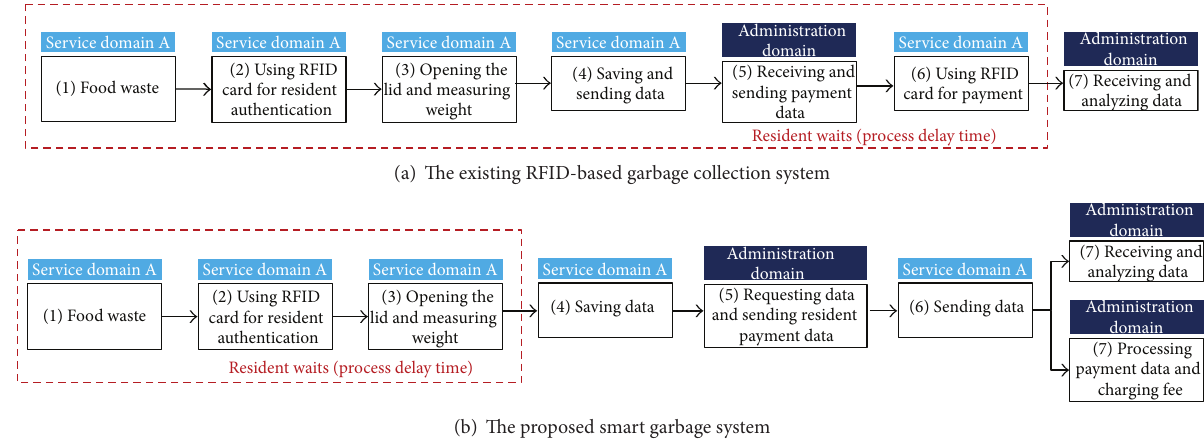
Figure 3: Discharge process of existing RFID-based garbage collection system and the proposed smart garbage system.